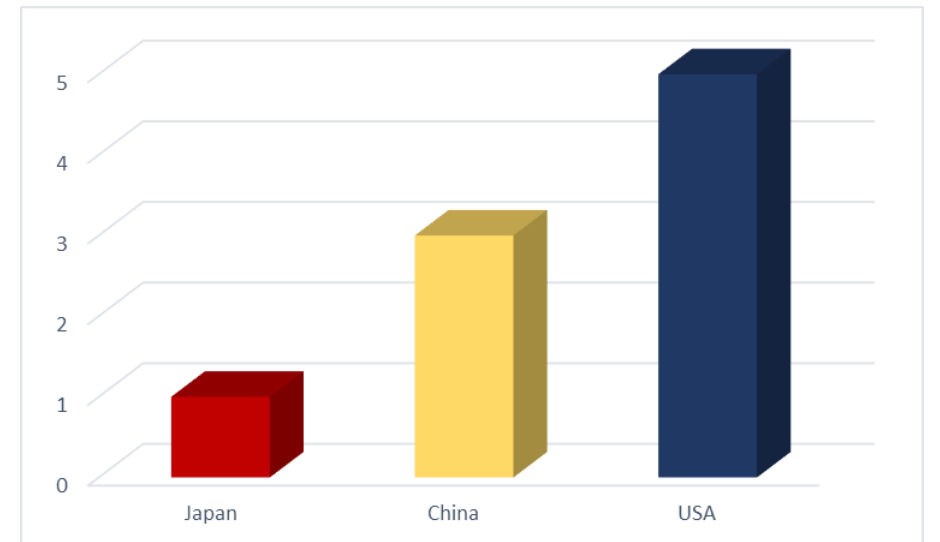
Figure 9. Only 9 patents related to water phytoremediation have been submitted, out of the 40 species that have been reported. In terms of the data collected in Table 2, the two countries with the most patents related with water phytoremediation are USA and China, followed by Japan.